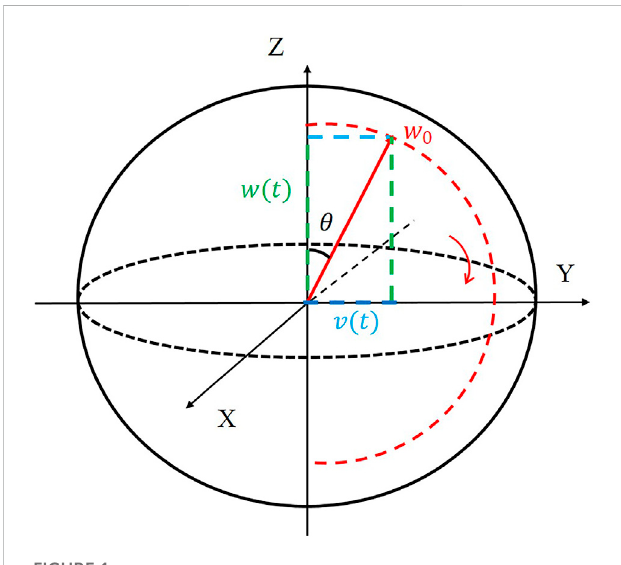
FIGURE 1 The Bloch vector B of the two-level system.